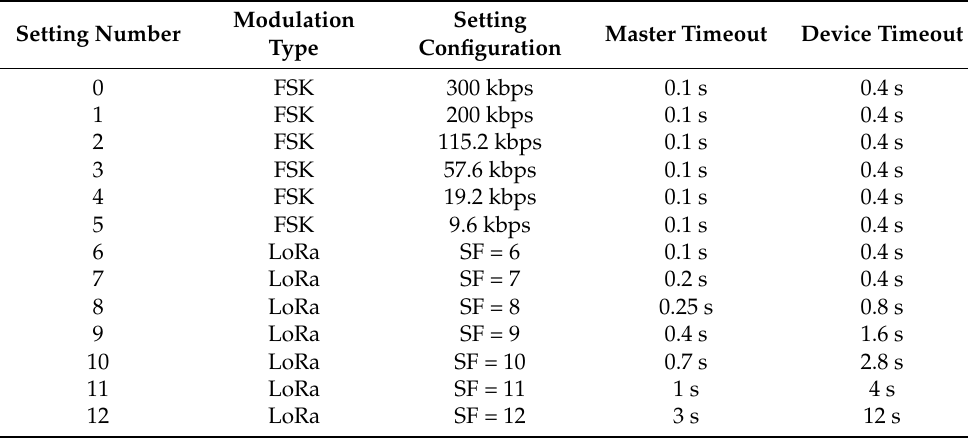
Table 2. The settings and timeout values used for adaptive data rate (ADR). Setting